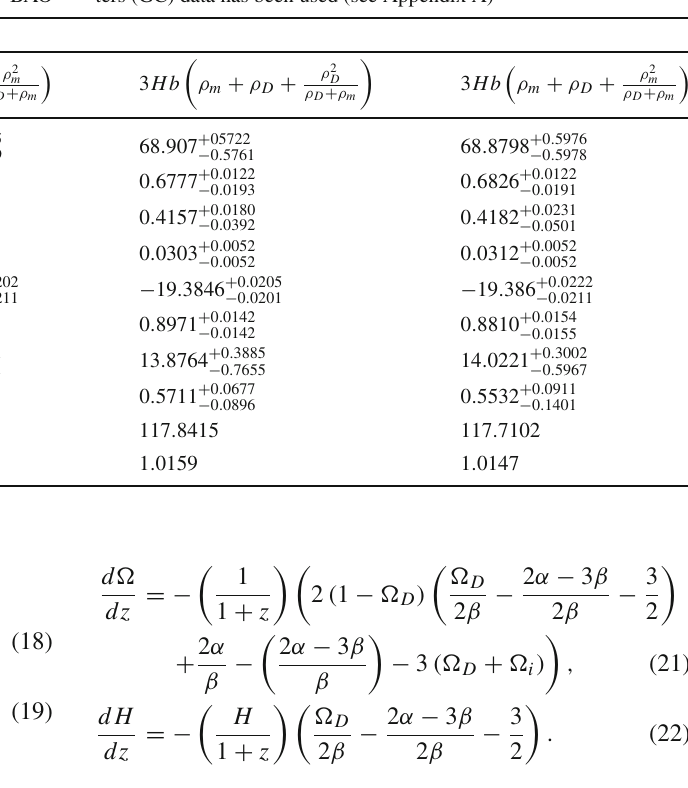
Table 2 The fitted values of cosmological parameters for the holographic Ricci dark energy model (Eqs. (15) and (16)) using linear and non-linear interactions listed in Table 1. The Pantheon supernova data, BAO BOSS DR12, CMB Planck 2015, fgas( gas mass fraction) and SZ/Xray (Sunyaev–Zeldovich effect and X-ray emission) data from